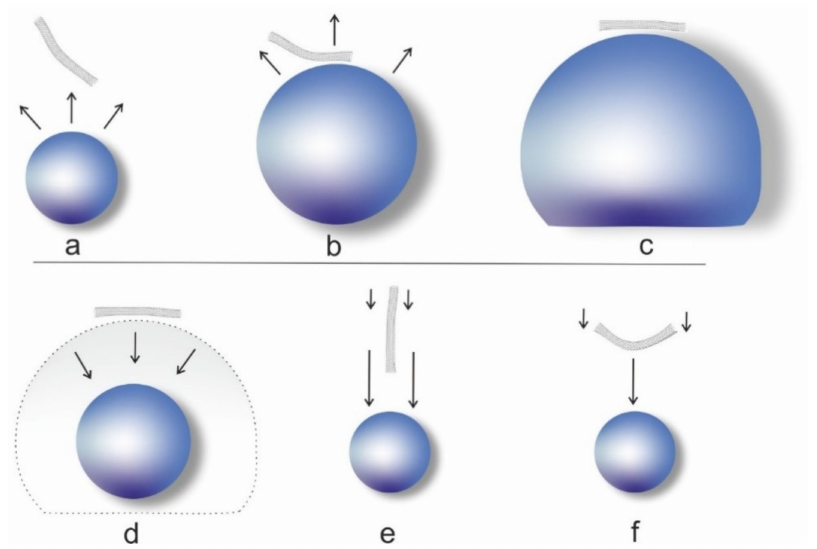
Figure 3. Effect of the cavitation bubble on the CNT, authors’ drawing inspired by [62]: ( a ) bubble growth in the vicinity of a CNT; ( b ) bubble begins to push and reorient CNT; ( c ) the CNT is oriented tangentially; ( d ) collapse of the cavitation bubble leads to a drag in the moving liquid that is faster in the center and slower towards the ends of the CNT, which leads to either ( e ) radial orientation with faster flow at the tip and slower flow at the end, which stresses the CNT, or ( f ) bending of the CNT in the center and subsequently